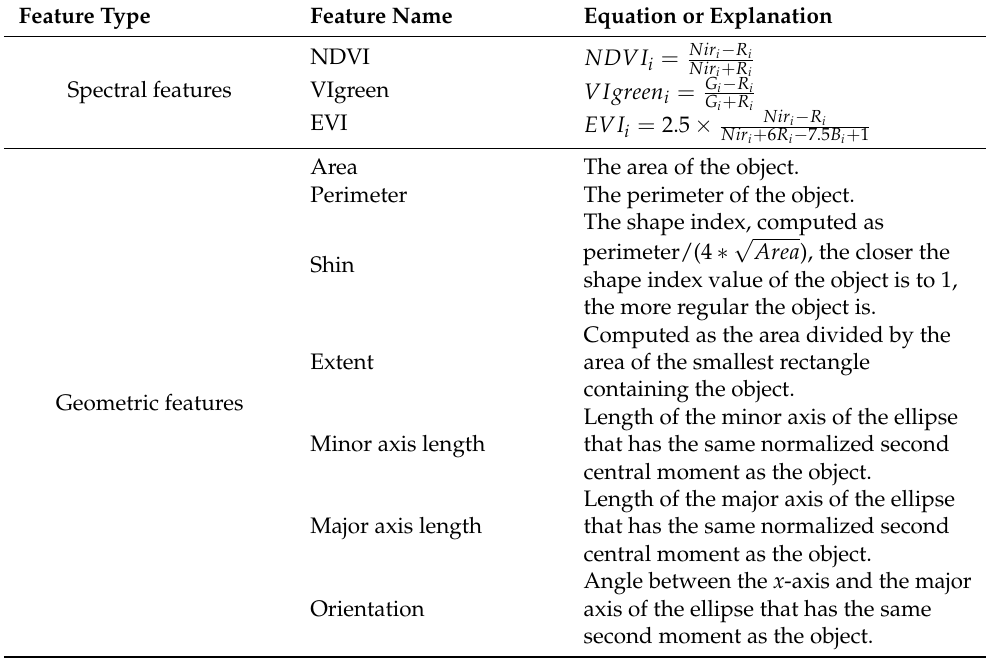
Table 2. List of the spectral and geometric features used in this study. The term “ i ” denotes the specific observation date of the remote sensing